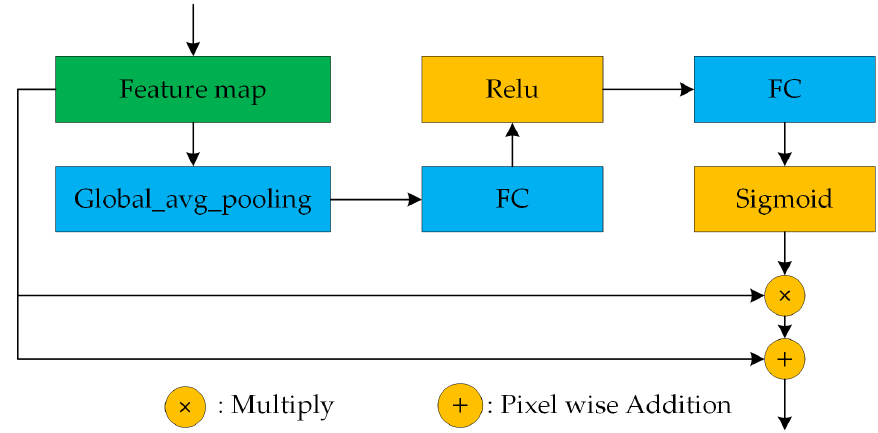
Figure 3. Core attention module.